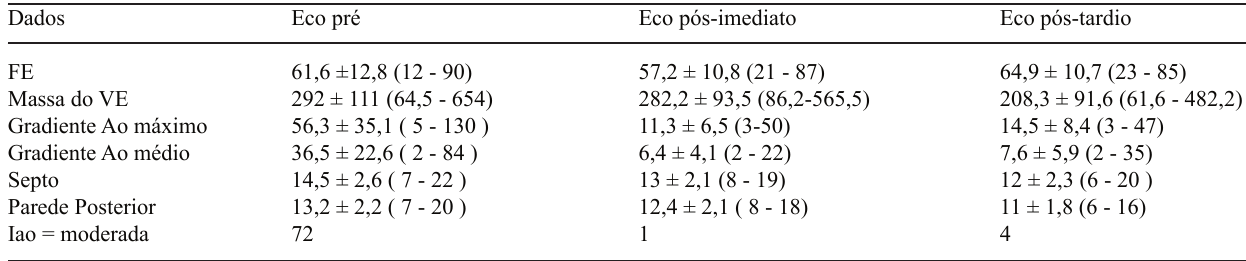
Tabela 4. Dados ecocardiográficos pré e